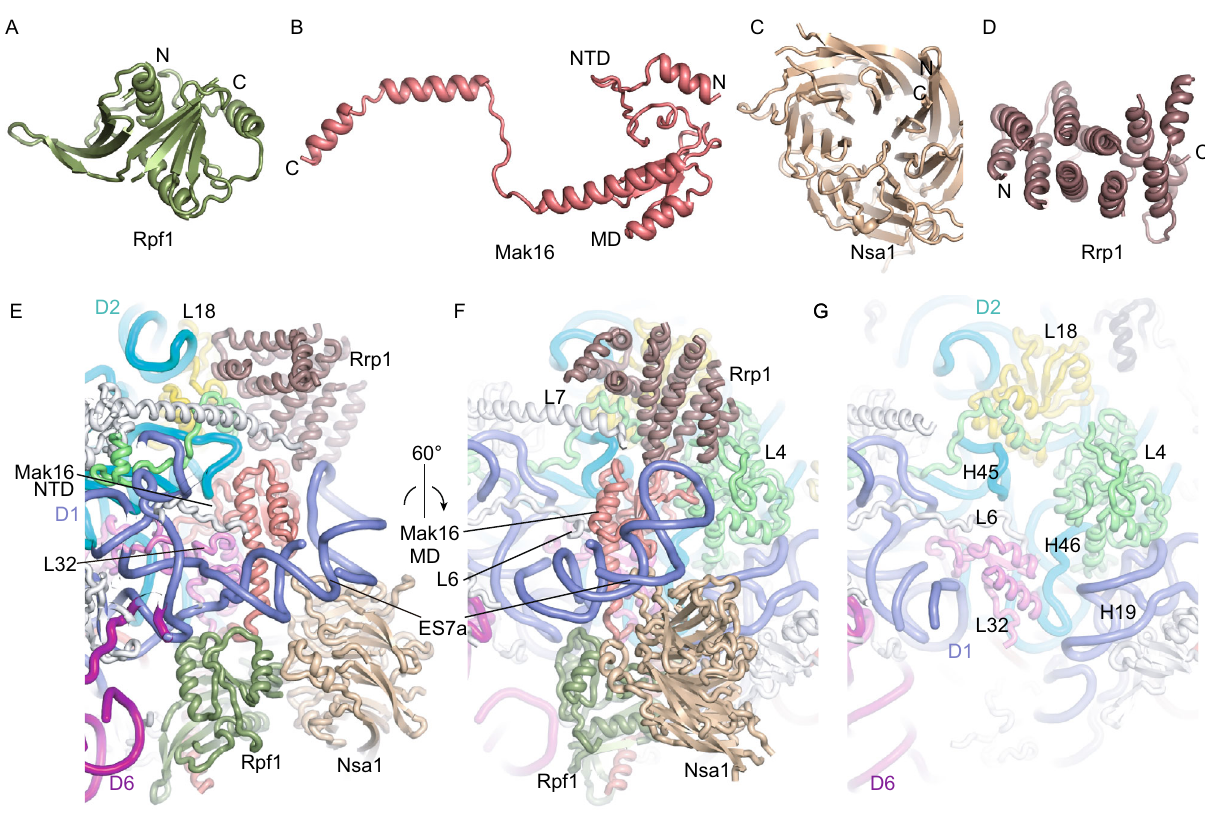
Figure 5. Assembly of D2 factors. (A – D) Structures of Rpf1 (A), Mak16 (B), Nsa1 (C) and Rrp1 (D). The N- and C-termini are labeled for each protein. The N-terminal domain (NTD) and middle domain (MD) of Mak16 are indicated. (E and F) Two views of Rpf1, Mak16, Nsa1 and Rrp1 assembled at the junction of domains I and II. AFs and individual domains of 25S rRNAs are color coded. L4, L18 and L32 are colored green, violet and yellow, respectively, and other RPLs are shown in gray. (G) Structure of mature 60S subunit (PDB code: 4V88) in the same view as